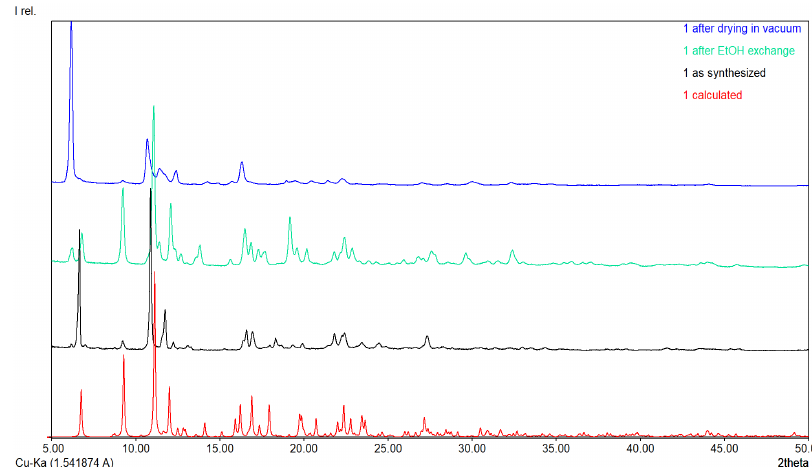
Figure 5. Diffractograms corresponding to compound 1 calculated from the cif file (red), as synthesized (black), after exchange with EtOH (green), and after drying in vacuum (blue).